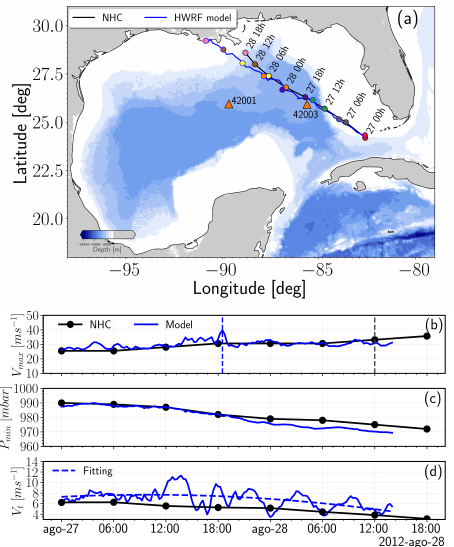
Figure 2. ( a ) Trajectory of hurricane Isaac reported by the NHC (solid black line) and the one obtained with the HWRF model (solid blue line). The colored dots represent the time of the simulation. The position of the NDBC buoys used here is denoted with triangle-shaped markers. ( b ) Time series of the maximum sustained wind at 10 m, ( c ) minimum pressure and ( d ) translation speed of the TC. The blue dashed line in ( b ) indicates the time at which the storm became a category 1 hurricane according to the model, whereas the date reported by the NHC is indicated with a gray dashed line. In ( d ), the blue dashed line represents the fitting of the V t values computed by the